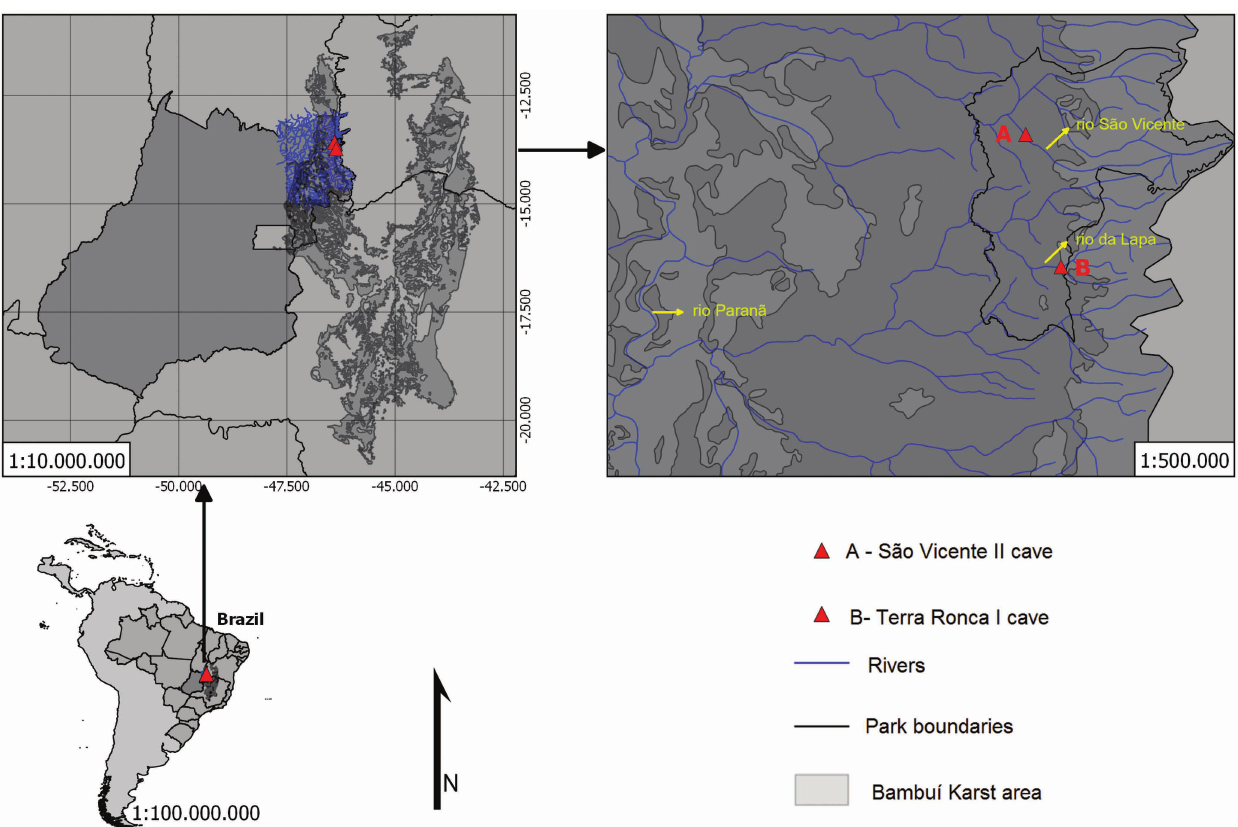
Fig. 1 . Map of São Domingos karst area showing the localities of Eigenmannia vicentespelaea and E. trilineata in the rio Paranã basin, upper rio Tocantins, with neighboring states. Inset: map of South